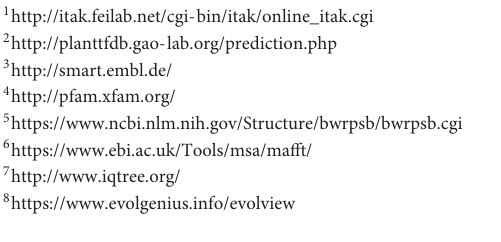
transcriptional factors, and extremely convergent gene loss was identified in two lineages of holoparasites, Balanophora and Sapria himalayana